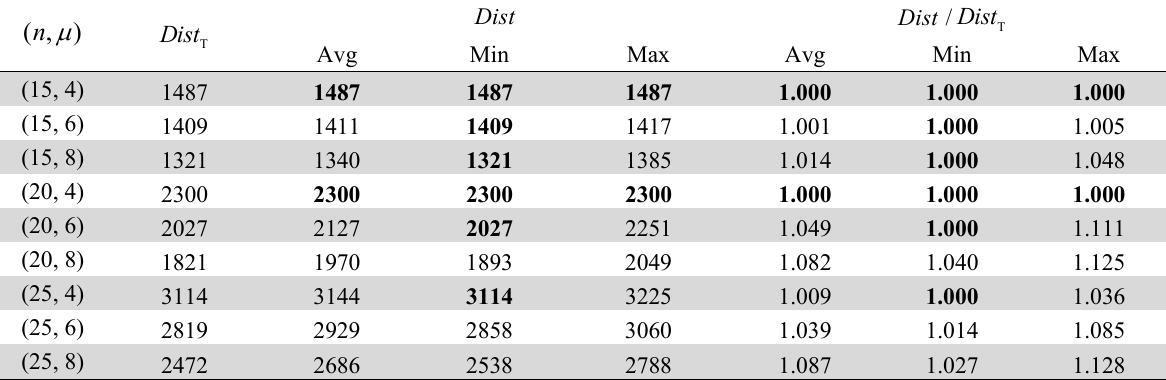
PF (triangles) for different n and A